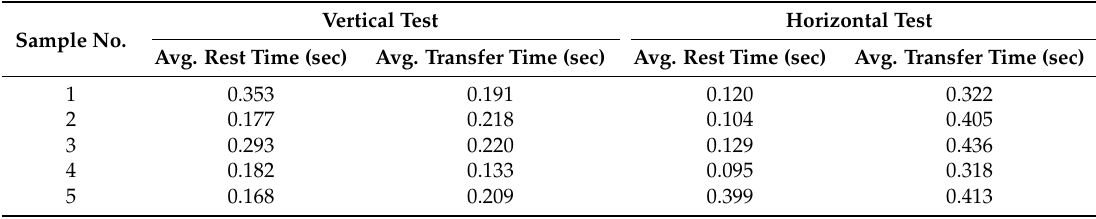
Table 9. Samples of the rest times and transfer times from five